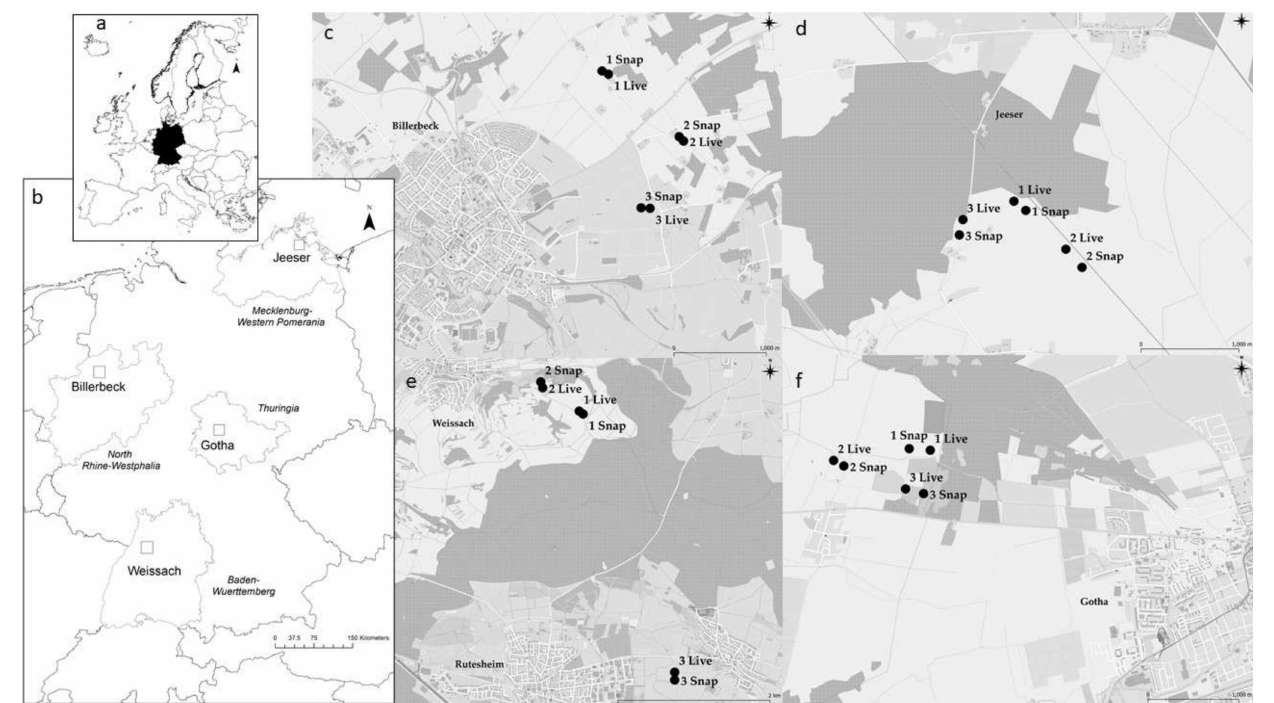
Figure 1. Map of the four study areas in Germany (( a ), overview) and the corresponding federal states (( b ), grey). In each area (Billerbeck ( c ), Jeeser ( d ), Weissach ( e ), Gotha ( f )), trapping was conducted on three replicate sites (1, 2, 3) where live (Live) and snap (Snap) trapping was performed. Dark-grey areas present forests and light-grey areas are agricultural/grassland areas where the trapping was